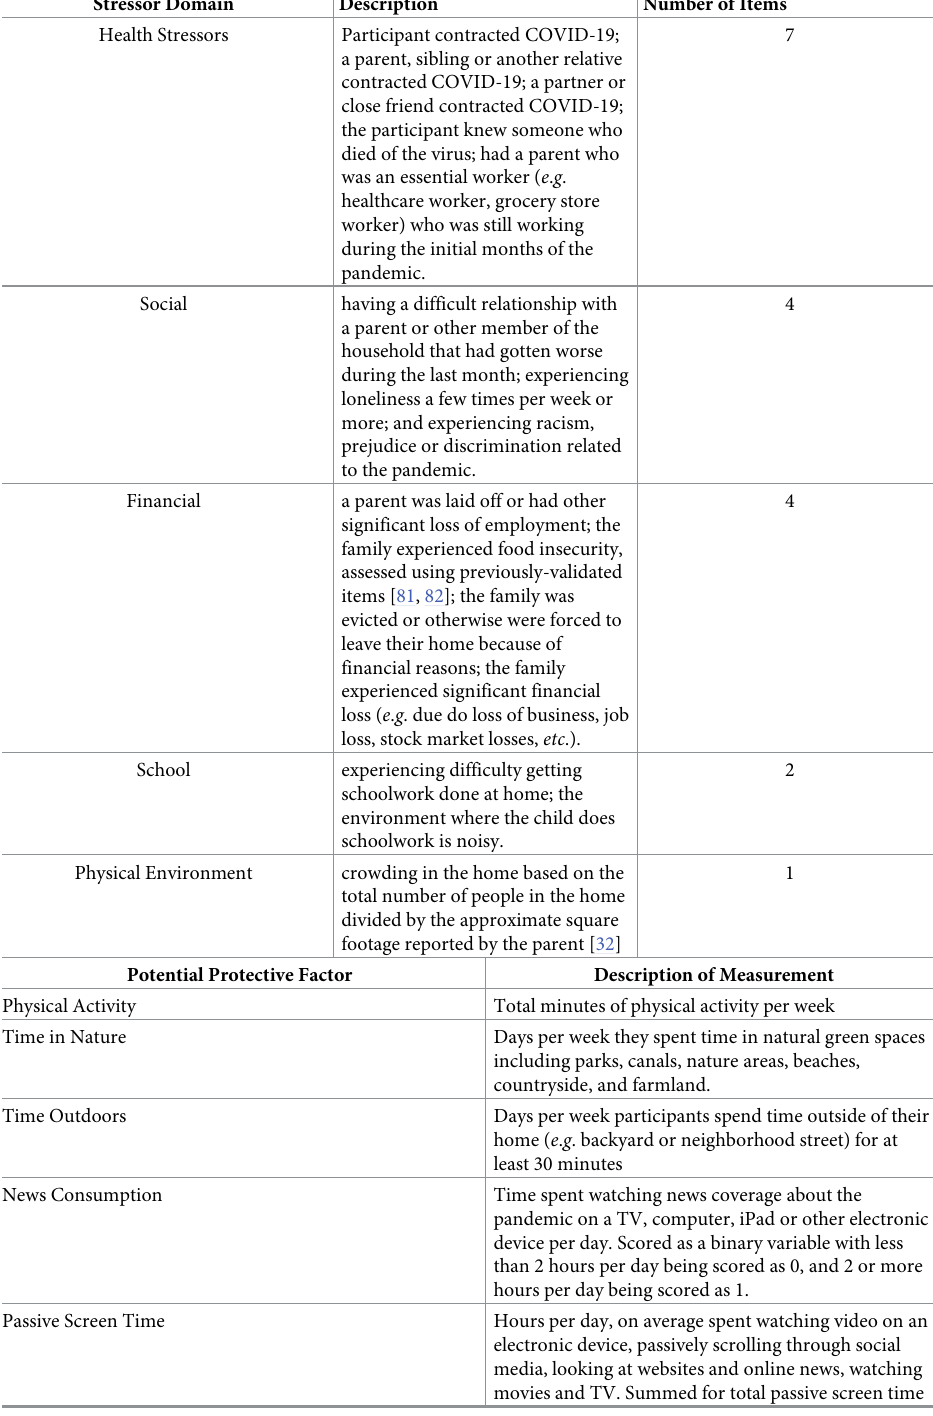
Table 1. COVID-19 pandemic-related stressors and potential protective